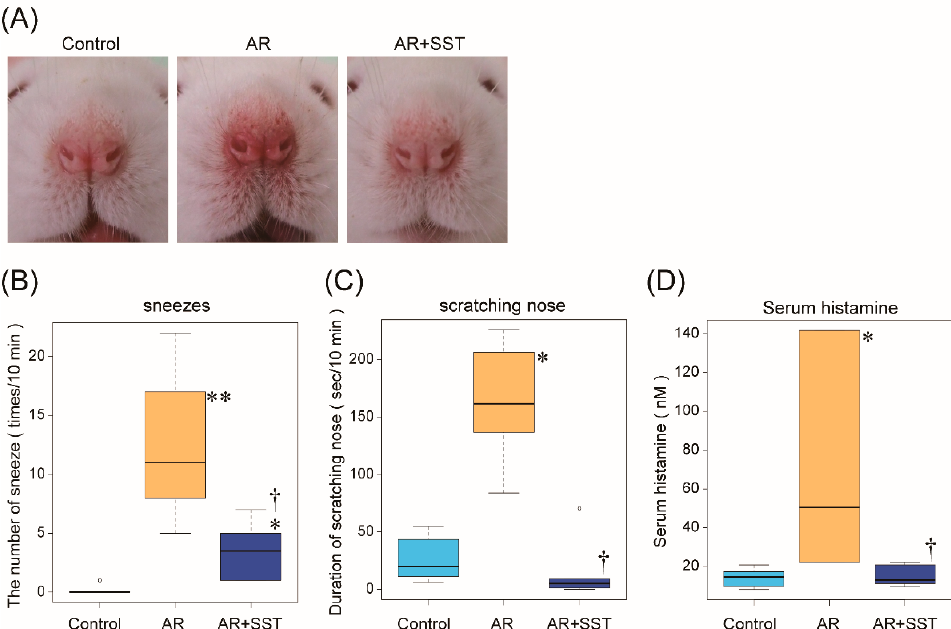
Figure 2. SST suppressed symptoms associated with AR. ( A ) Nose appearance of TDI-sensitized rats. Note, redness and swelling of nose appeared in AR rat is subsided in SST-treated rat. ( B ) The number of sneezes during 10 min immediately after the last TDI-induced (ethyl acetate for control) provocation. (n = 6) * p < 0.05, ** p < 0.01 vs. Control group; † p < 0.05 vs. AR group. (Kruskal-Wallis tests) ( C ) Duration of scratching nose for 10 min after the last TDI (ethyl acetate for control) provocation. Values are the mean ± SEM. (n = 6) * p < 0.05 Control group; † p < 0.05 vs. AR group. (Kruskal-Wallis tests) ( D ) Serum histamine concentration of rats. Values are the mean ± SEM. (n = 6) * p < 0.05 Control group; † p < 0.05 vs. AR group. (One-way ANOVA followed by Tukey’s multiple compari- sons).